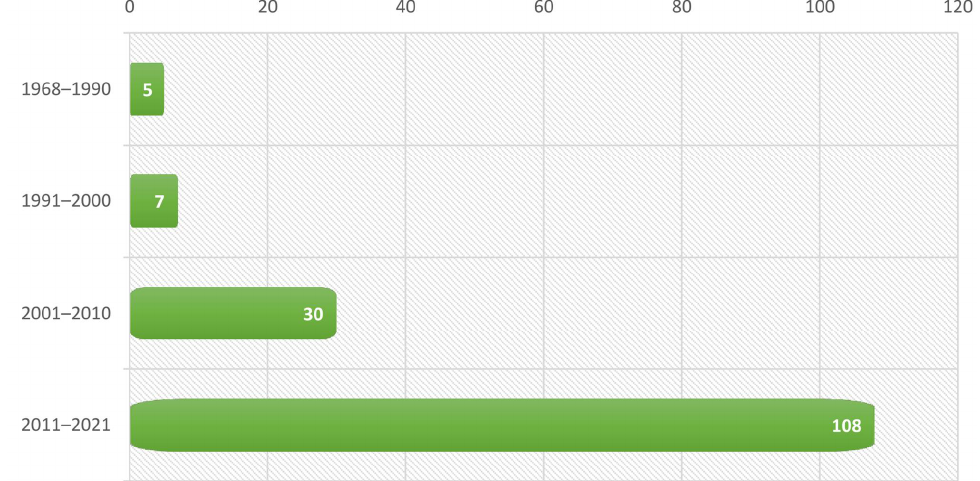
Figure 1. Number of studies for the systematic literature review—a timeline.